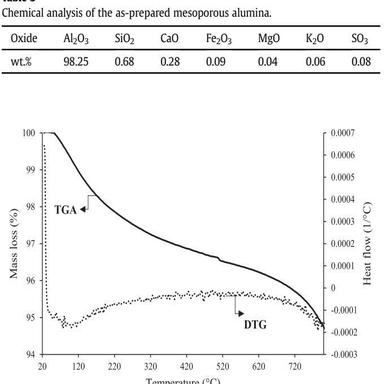
TGA and DTG profiles of the as-prepared mesoporous alumina.